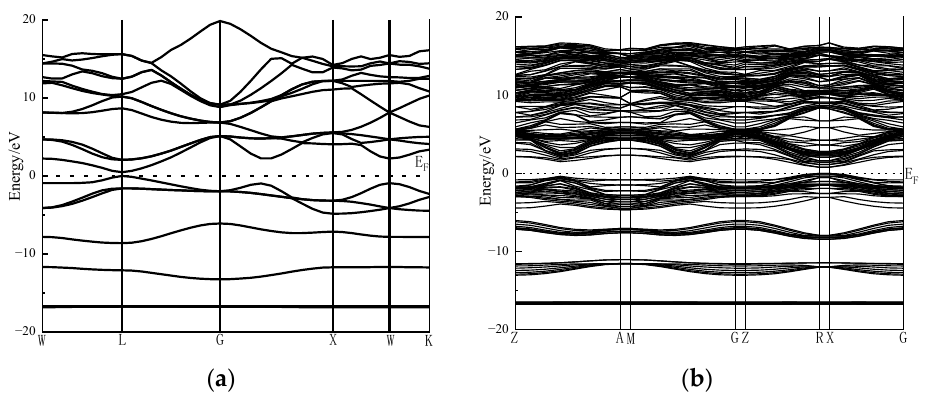
Figure 8. Band structure of bulk galena ( a ) and (100) surface ( b ).